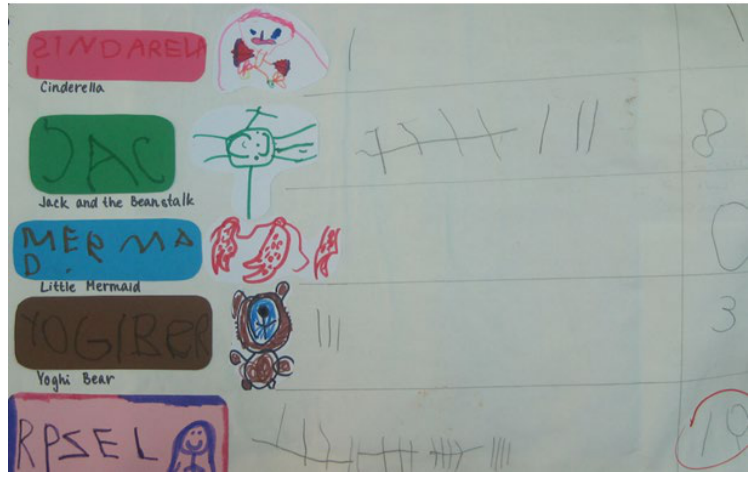
Figure 5: Four-year-olds’ tally of their favourite fairy tale